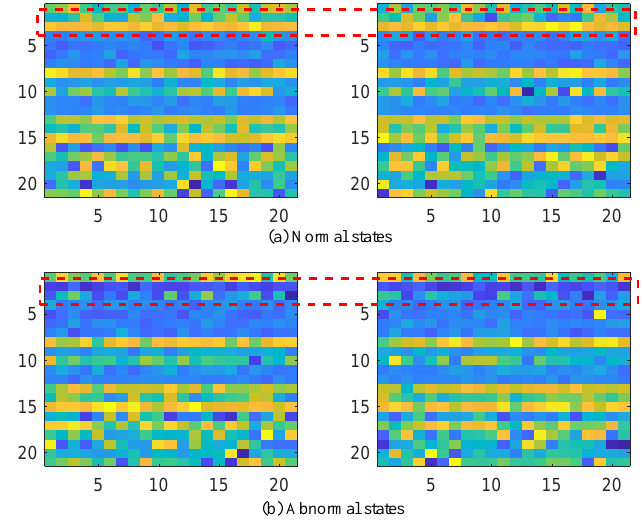
Figure 11. Comparison of normal and